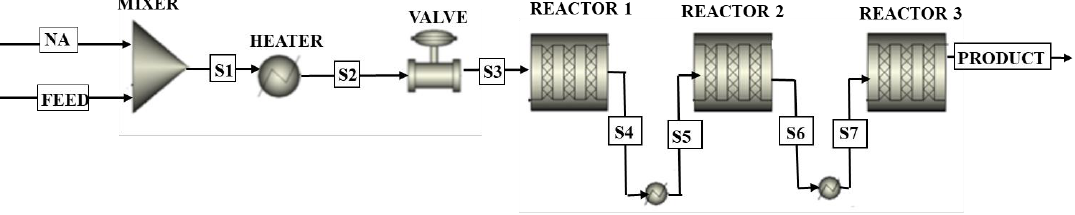
Figure 6. The flowsheet of semi-regenerative process plant in ASPEN Plus ® .